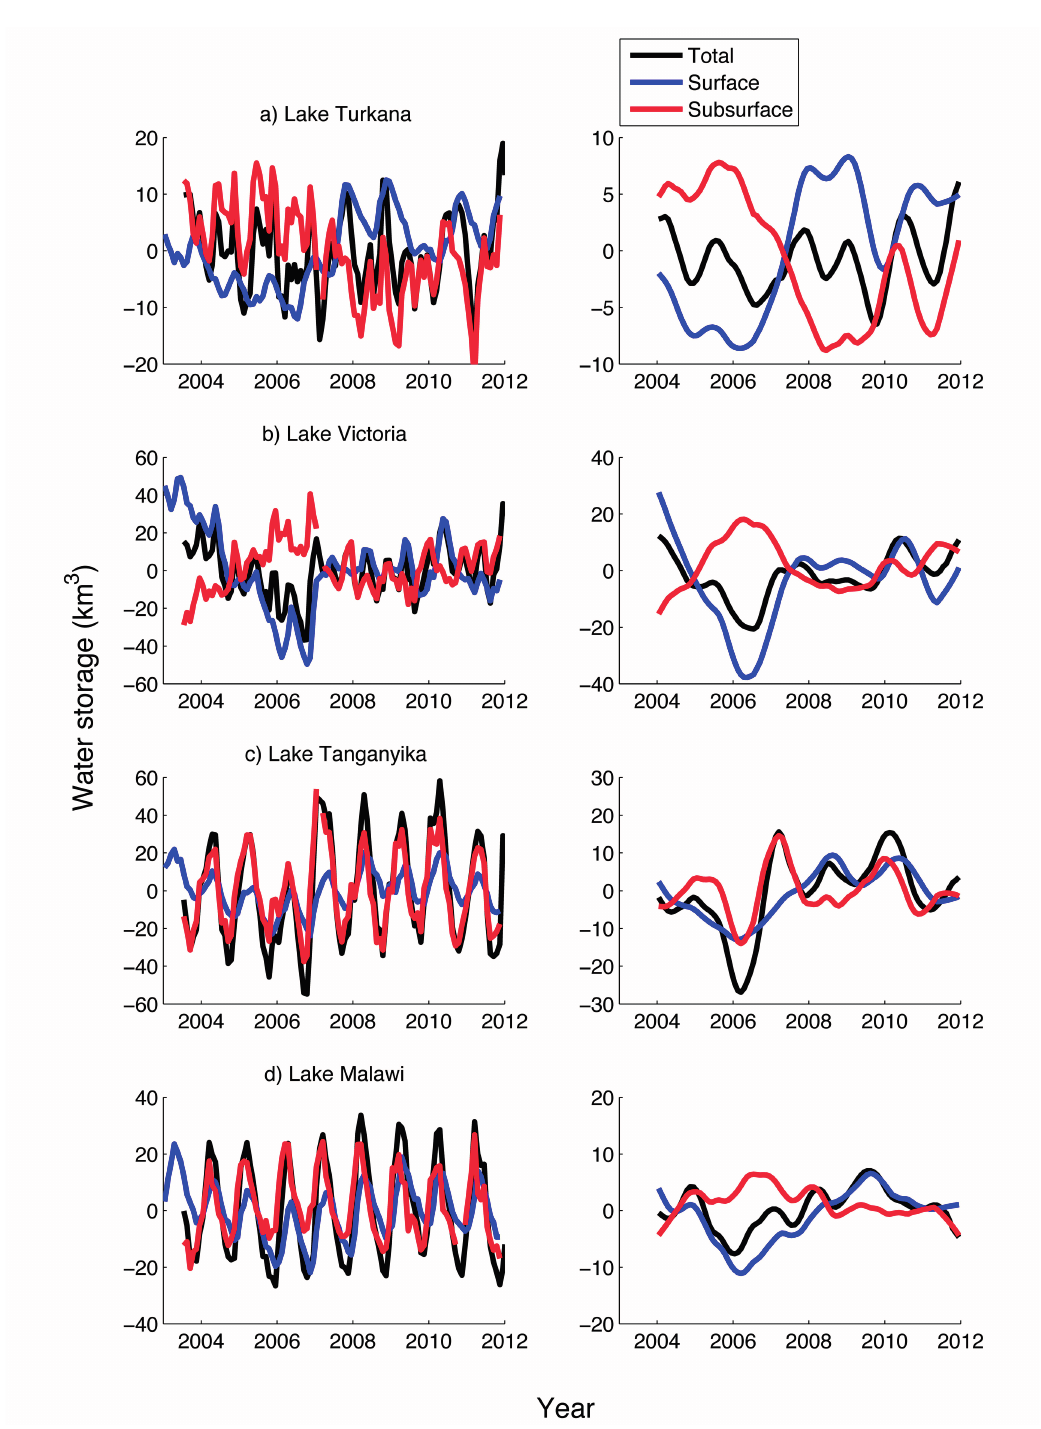
Figure 13. Time-series of the anomaly of the water storage of TWS (black), of the surface reservoir (blue) and of the subsurface reservoir, including groundwater (red), in the left column, and their inter-annual variations, in the right column, for Lake Turkana ( a ), Lake Victoria ( b ), Lake Tanganyika ( c ) and Lake Malawi ( d